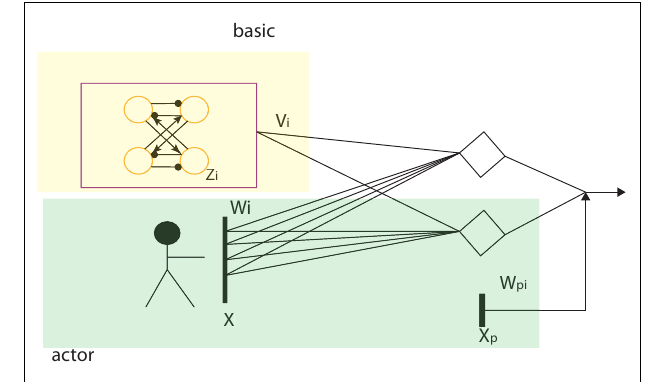
FIGURE 3 |The feed-forward two-layer neural network as the core of the CPG network. The yellow area is the basic CPG part with fixed connection weights and the green area functions for the output integration of sensor neurons and posture